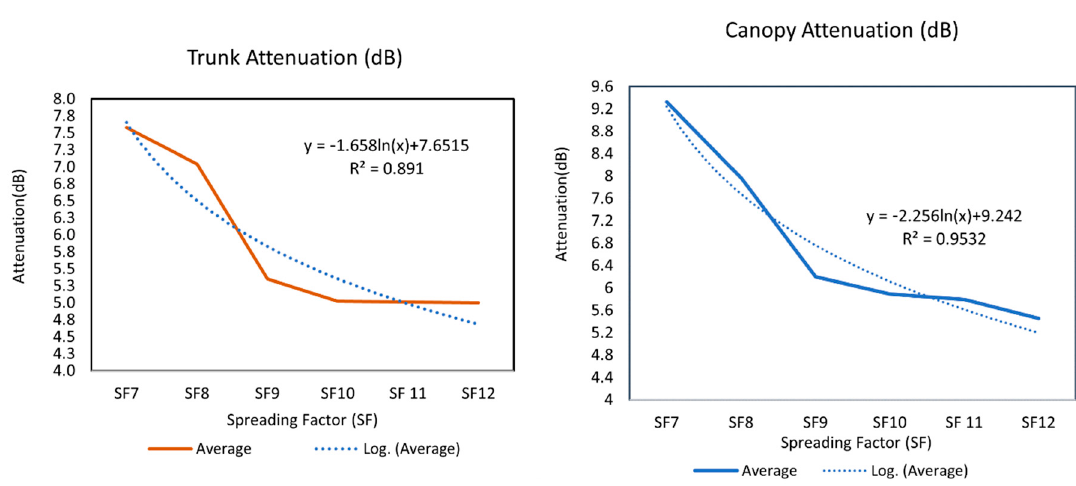
Figure 7. Trunk and canopy attenuation functions.